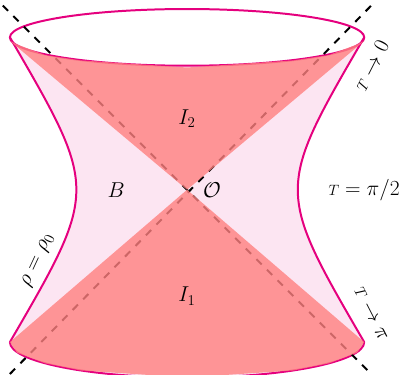
Figure 2 . The region where we de(cid:12)ne the action problem. It is con(cid:12)ned by initial and (cid:12)nal cones I 1 and I 2 (e.g. at constant T ), intersecting at O . The region is not bounded in (cid:26) direction, so I 1 ; 2 are Cauchy surfaces where initial and (cid:12)nal data are (cid:12)xed. The boundary terms are computed at constant- (cid:26) hyperboloids ( B ). Dashed lines show the